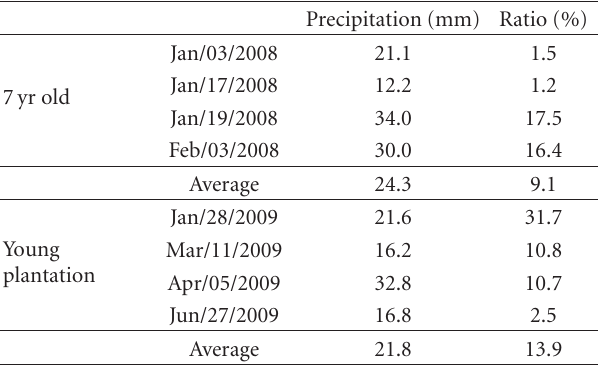
Figure 3: Map of the experimental catchment showing the identi- fied hydrologically sensitive areas.